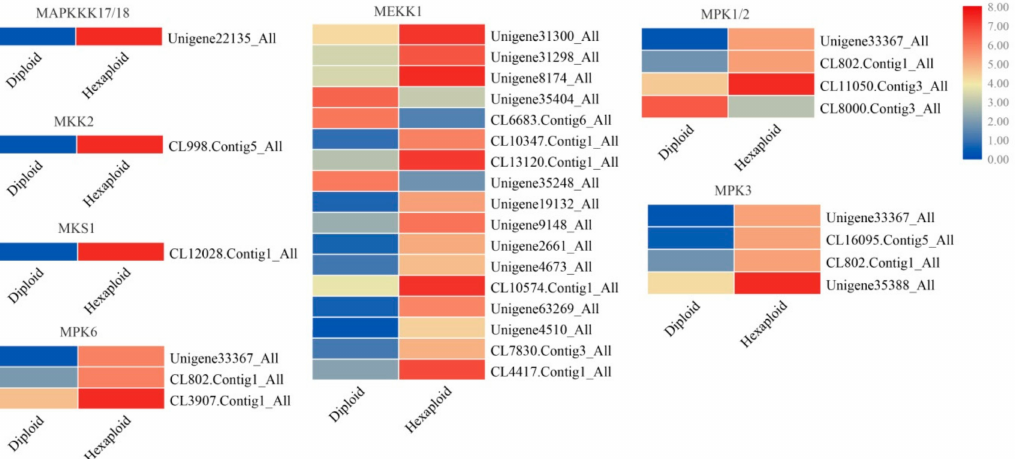
Figure 6. Expression profiles of enriched MAPK signal transduction related DEGs. The DEGs that play a major role in the transduction are depicted. The color bar indicates the normalized relative expression levels; red indicates high expression level, blue indicates low expression